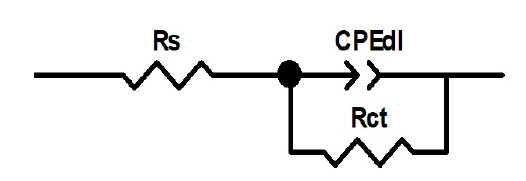
Figure 6. Equivalent circuit used to fit the EIS data.